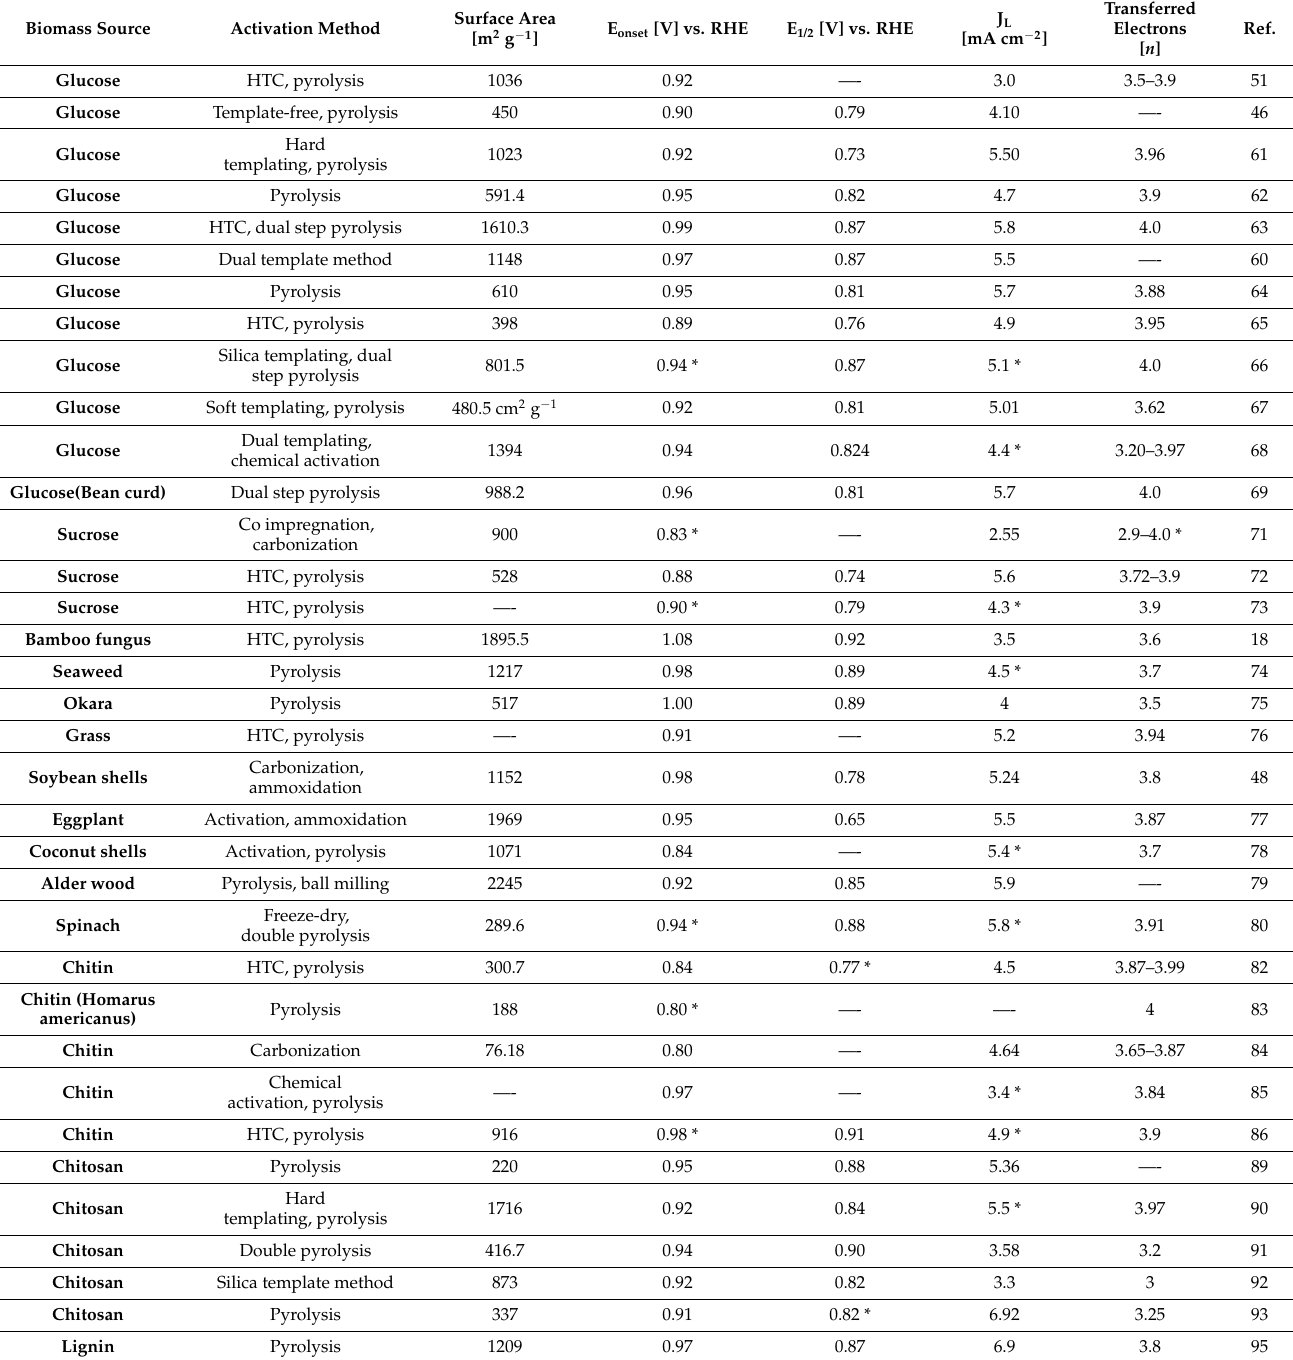
Table 1. A list of ORR electrocatalysts derived from different types of